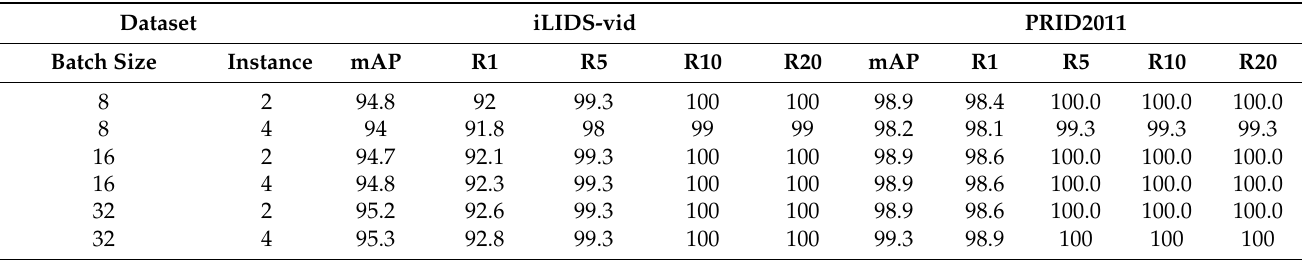
Table 6. Comparing Our Model’s Accuracy Using Different Batch Sizes and Instances.